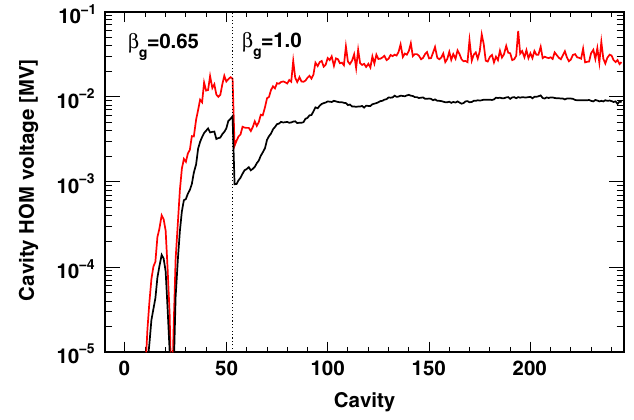
FIG. 6. Average (black) and maximum (red) HOM voltage present in the cavities after two pulses. The ð R=Q Þ dency is clearly visible in the medium beta section. Settings: N ¼ 1000 , see Table